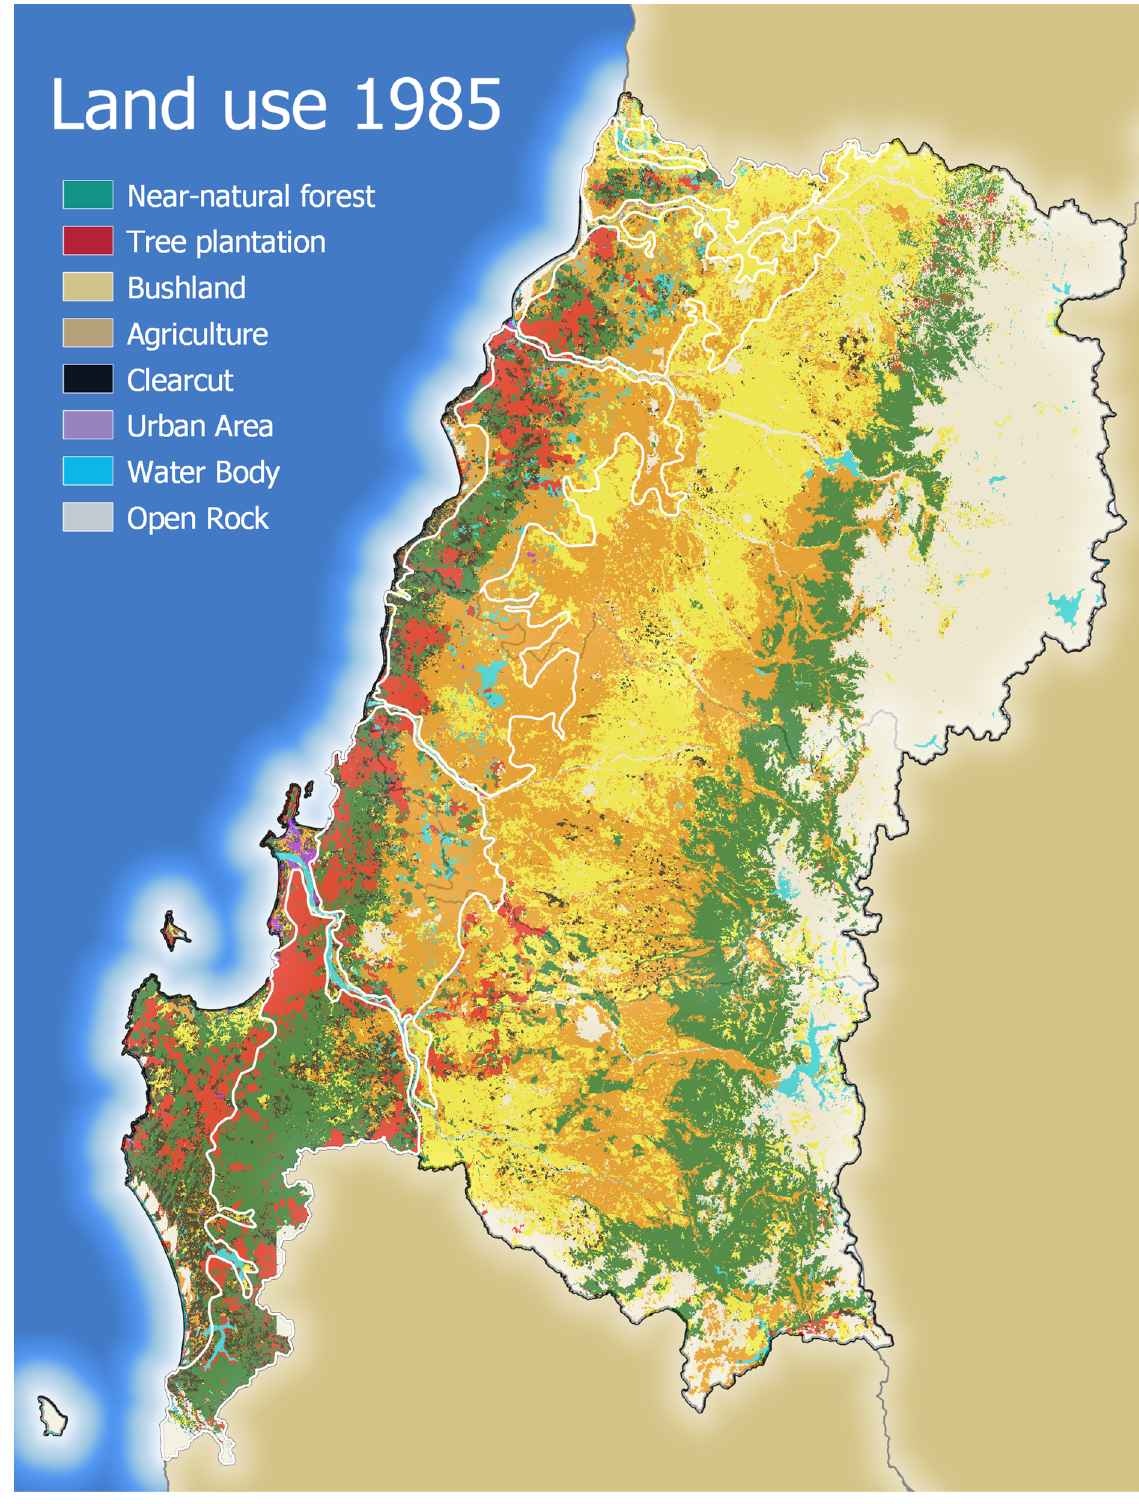
Figure A3. Land use map of study site in 1985.